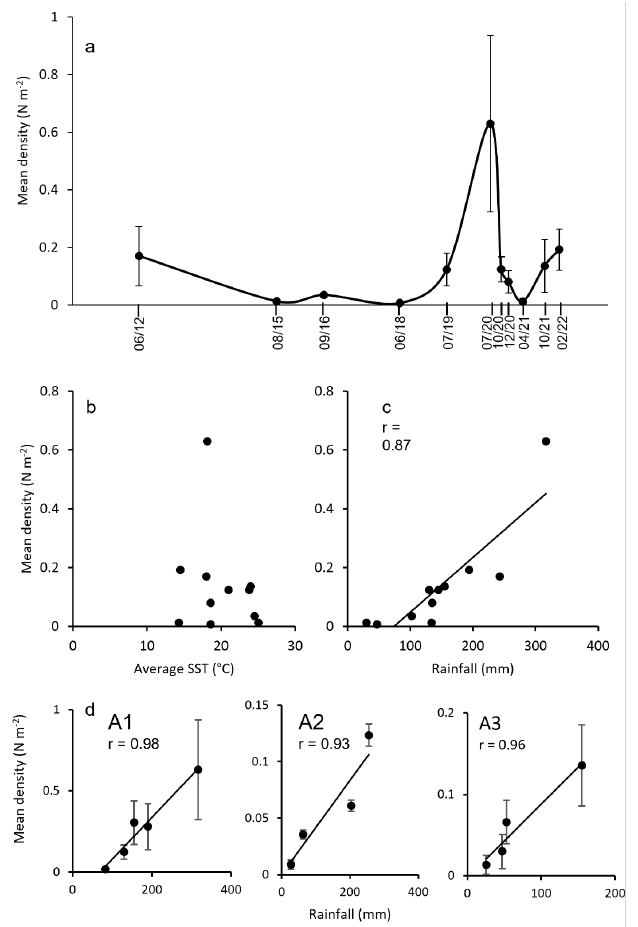
Figure 7. ( a ) Trend of the basket star density (± SE) in the entire sampling period. ( b ) Correlation of Astrospartus mediterraneus density vs the mean SST in the three months before the sampling. ( c ) Correlation of A. mediterraneus density vs total rainfall in the three months before the sampling. ( d ) A1 – A3, Correlation of the density vs rainfall during the summer months (June-September) in the three macro-areas.